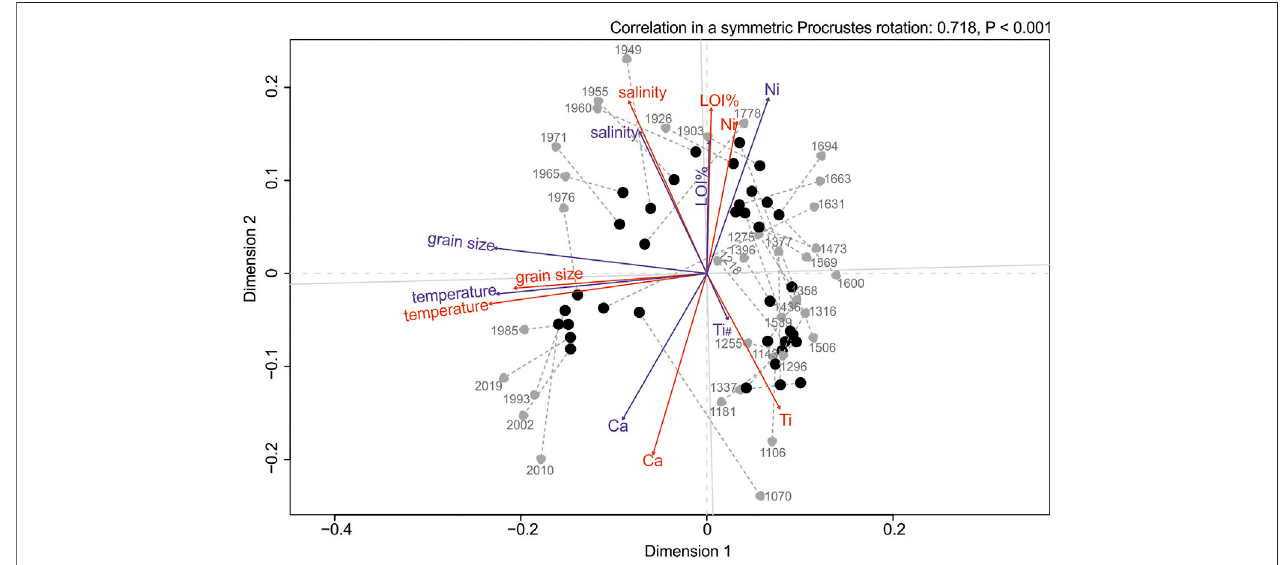
FIGURE 2 | Procrustes test plot demonstrating the dbRDA ordination correlations between diatom communities recovered in valves (gray circles) and sedaDNA (black circles) data. The gray dashed lines point to the con fi guration in valve data ordination. Dark gray numbers (from 1070 to 2019) denote sample names, which correspond to the sediment layer date [year CE, weighted mean age of the core layer ( Supplementary Table S2 )]. Vectors on the plot denote environmental variables fi tted onthegraphwith en fi t function(red: vectors forvalvedata,blue: vectorsfor sedaDNAdata; # inthevectorname denotes non-signi fi canceasbasedon env fi t